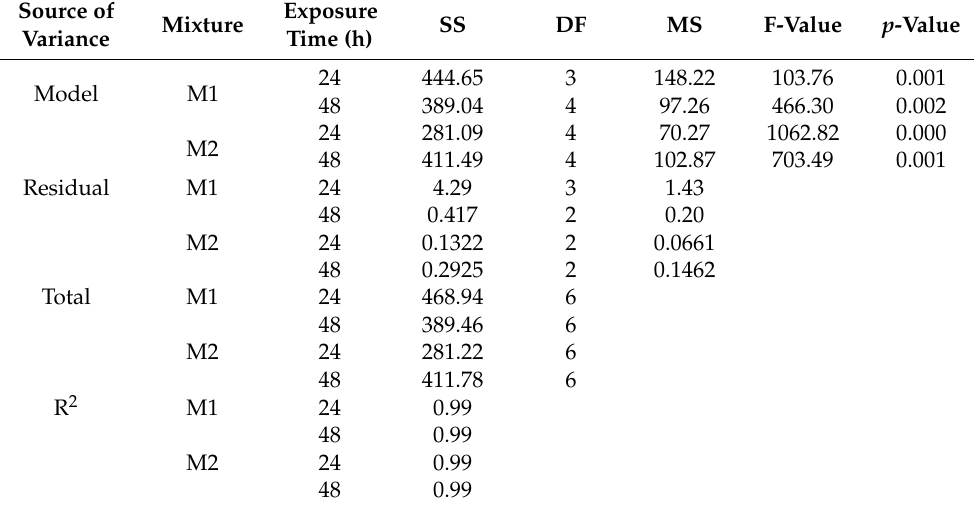
Table 4. Analysis of variance for the adjusted model for all selected